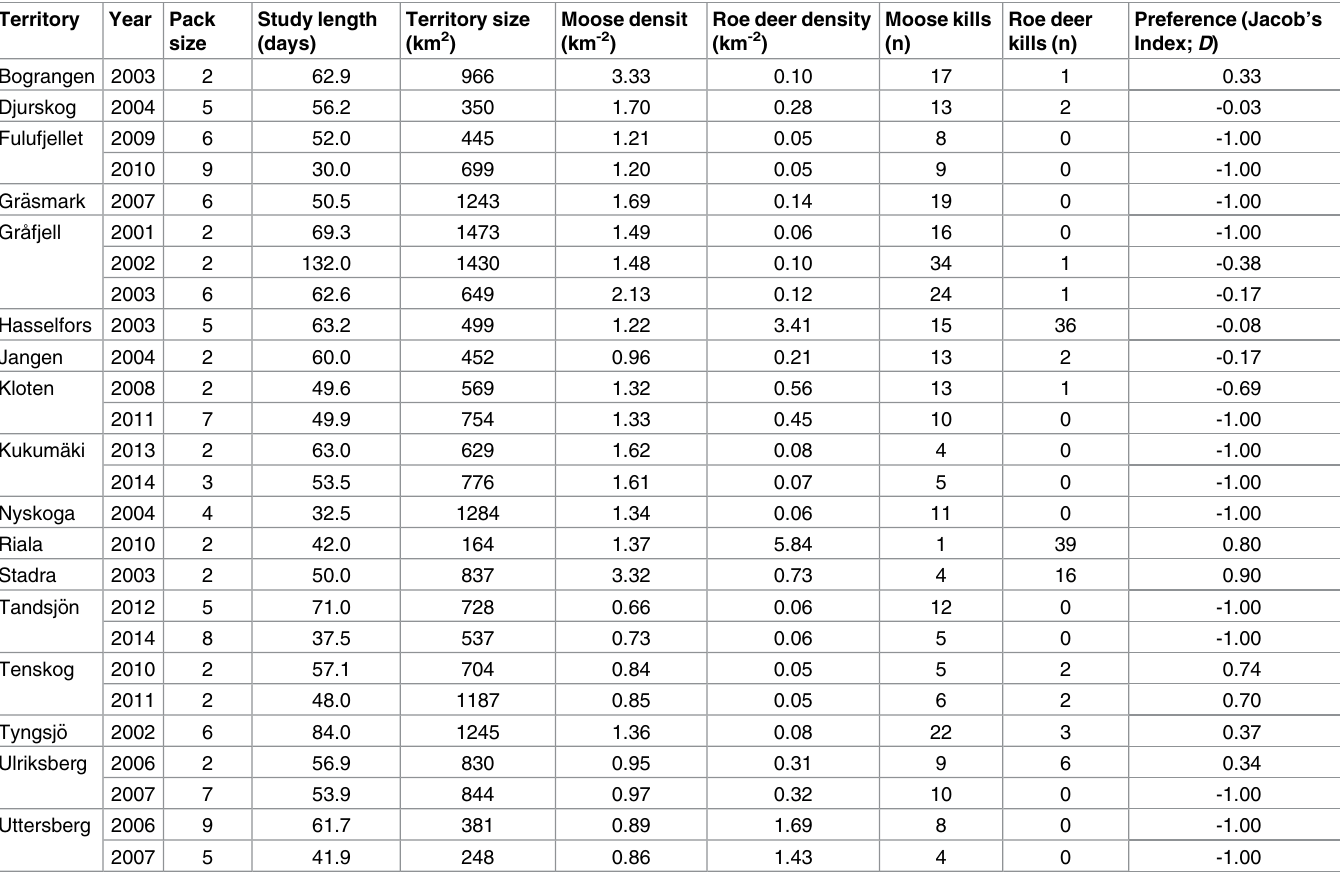
Table 1. Data from the 26 predation studies performed in 17 different wolf territories in Scandinavia during 2001–2014with year and length of study, wolf pack size, territory size (100% MCP), moose and roe deer densities, and number of moose and roe deer killed by wolves. Also included is the Jacob’sindex for the preference of roe deer ( D